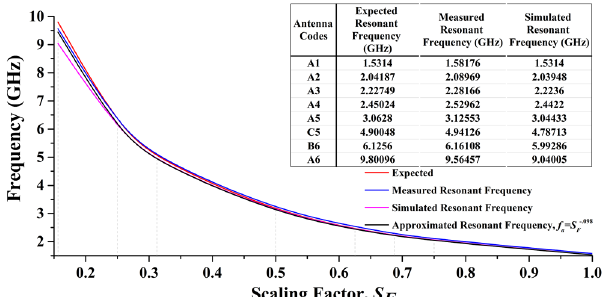
Figure. 4. The simulated, measured and expected resonant frequency of antennas. The “Approximated Resonant Frequency” models the behavior of “Measured Resonant Frequency” curve mathematically and is slightly different form theoretical predictions, p =0.98 instead of p =1.